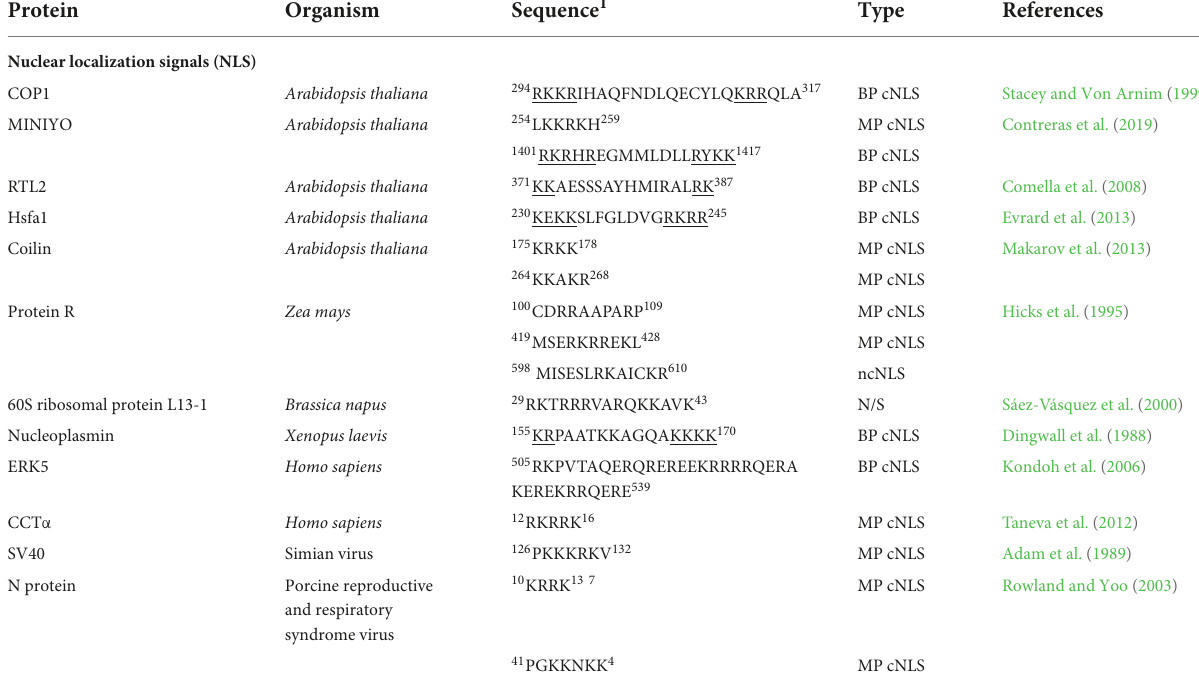
TABLE 2 Nuclear localization signals.